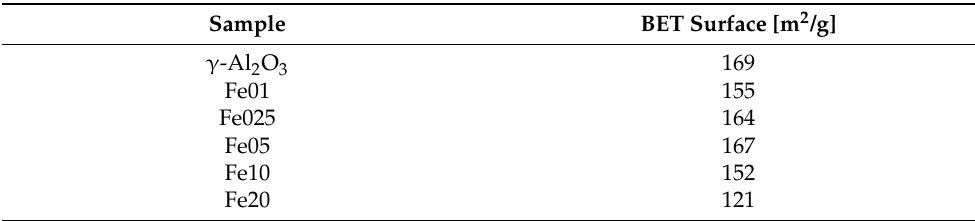
Table 1. Specific surface areas of Fe01 to Fe20 compared to the pure γ -Al 2 O 3 support, obtained via BET